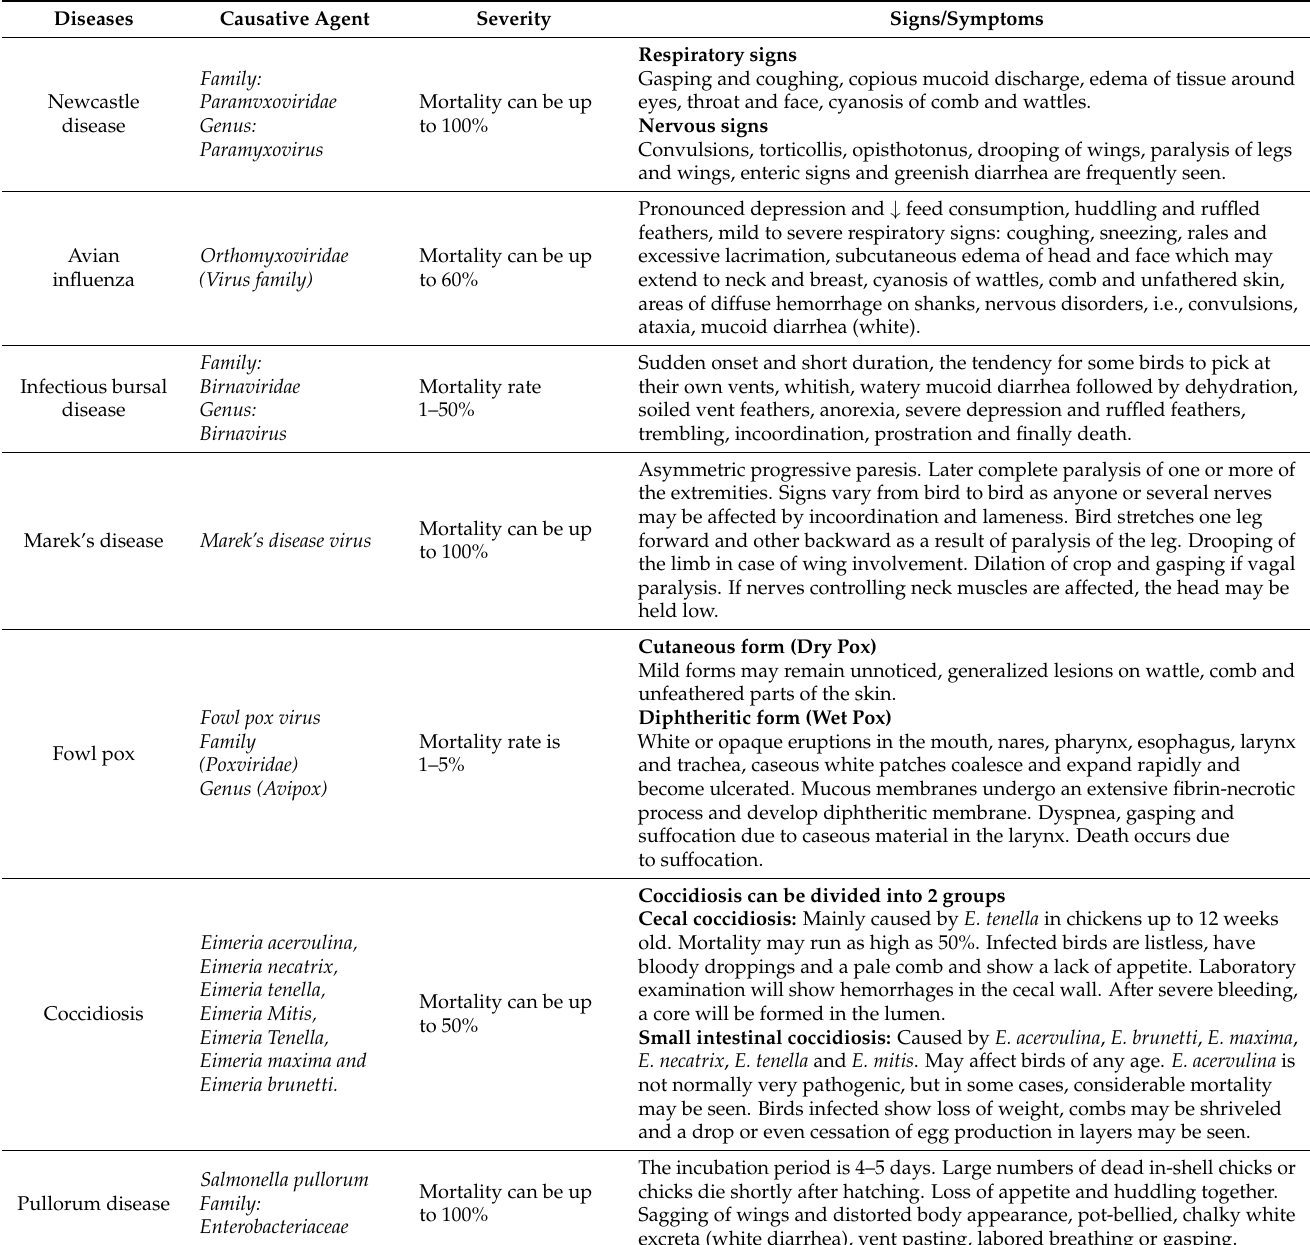
Table 3. The clinical signs/symptoms and corresponding management measures of common chicken diseases [94,95]. These clinical signs/symptoms could be used as monitoring indexes of disease early